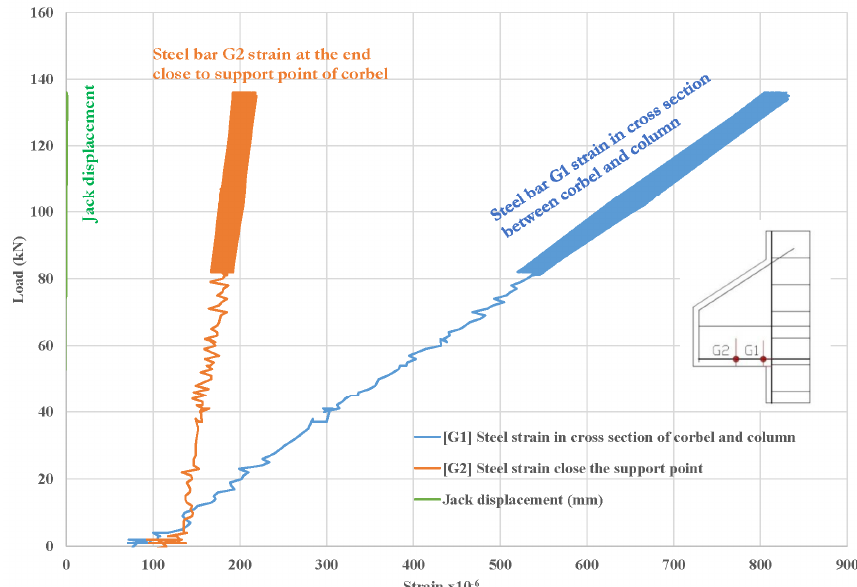
Figure 5: Strains of steel bar in cross section and support load point of corbel ("C0" fatigue).